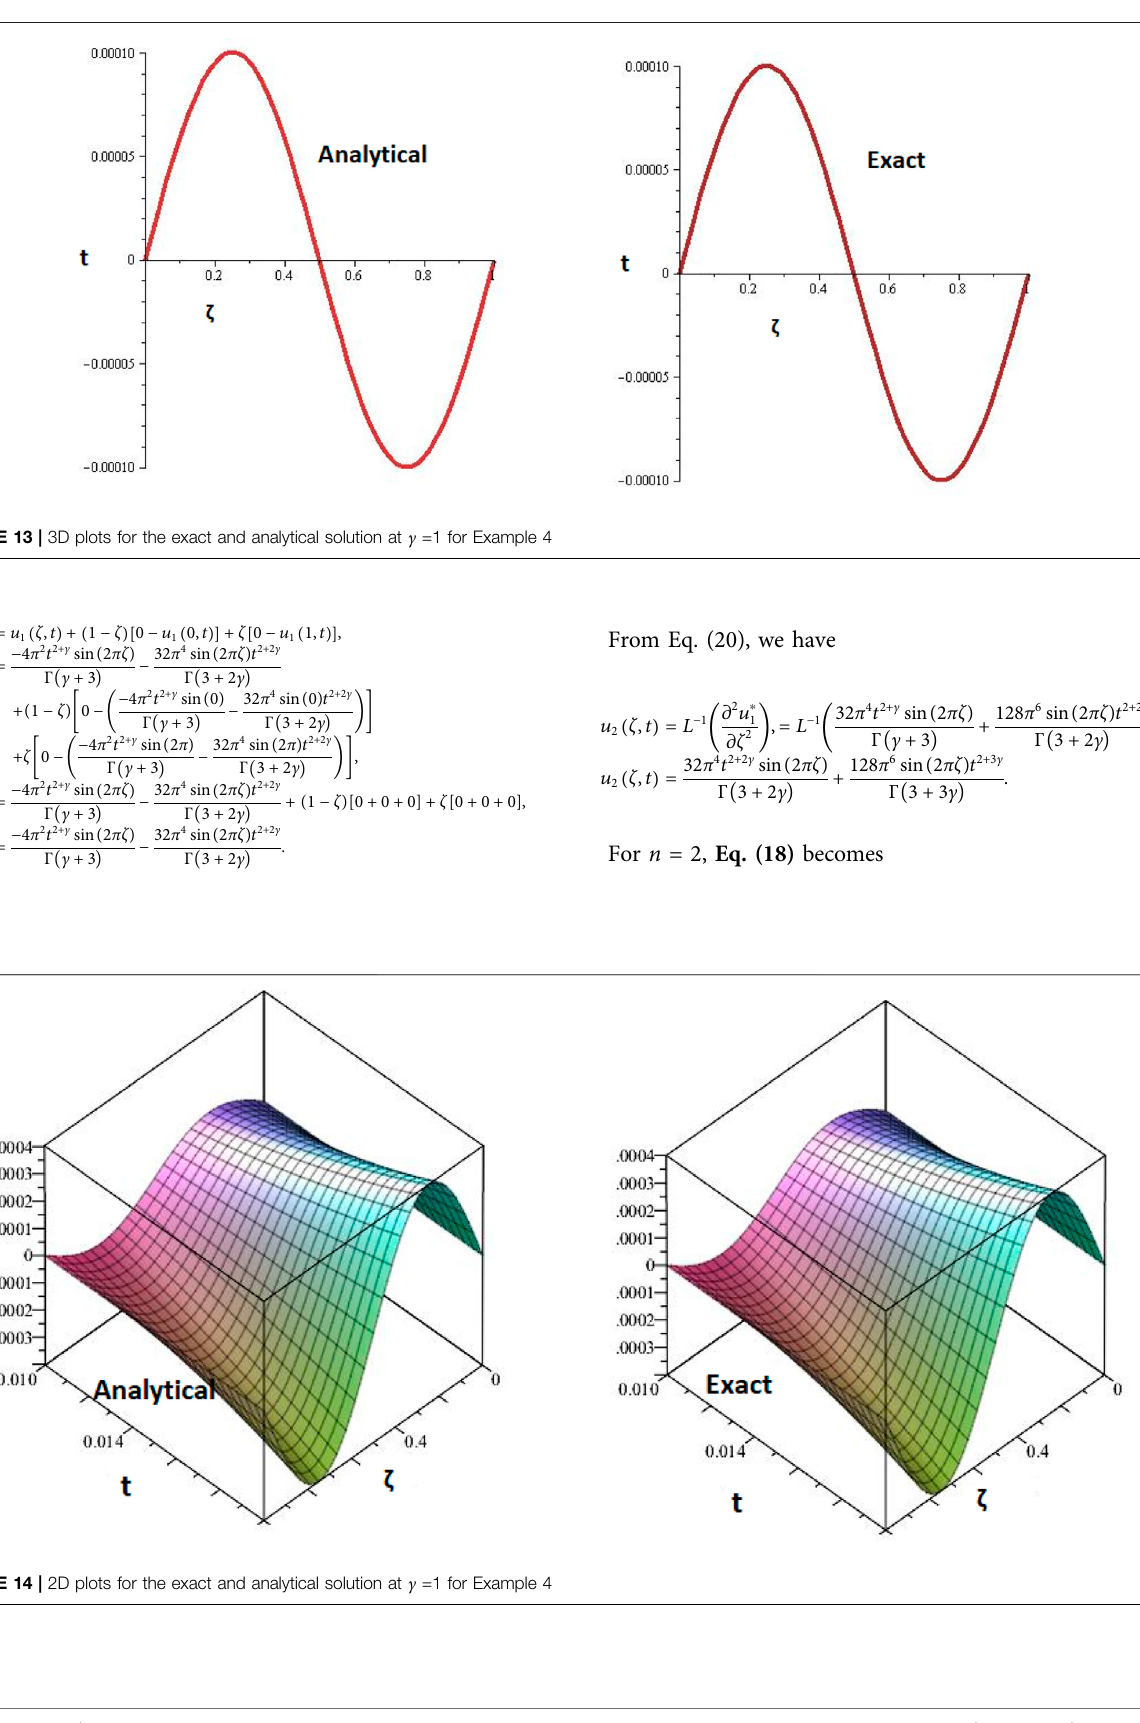
Frontiers in Physics |